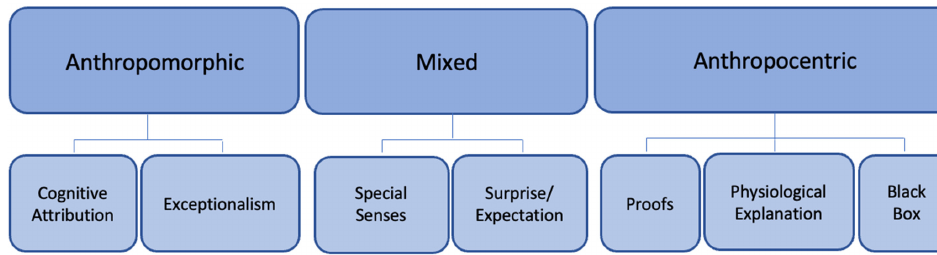
Figure 1. Constructions of Animal Empathy .